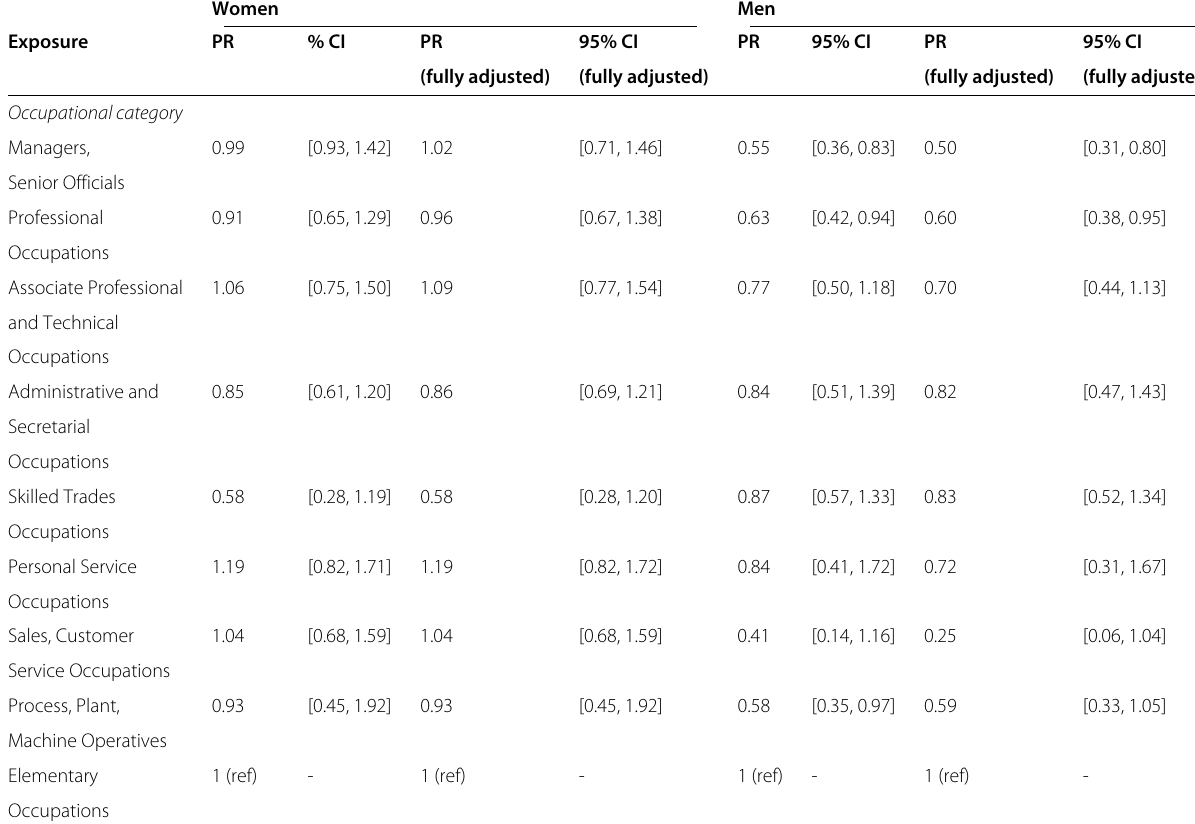
Table 3 Prevalence of migraineurs among different occupational categories Women